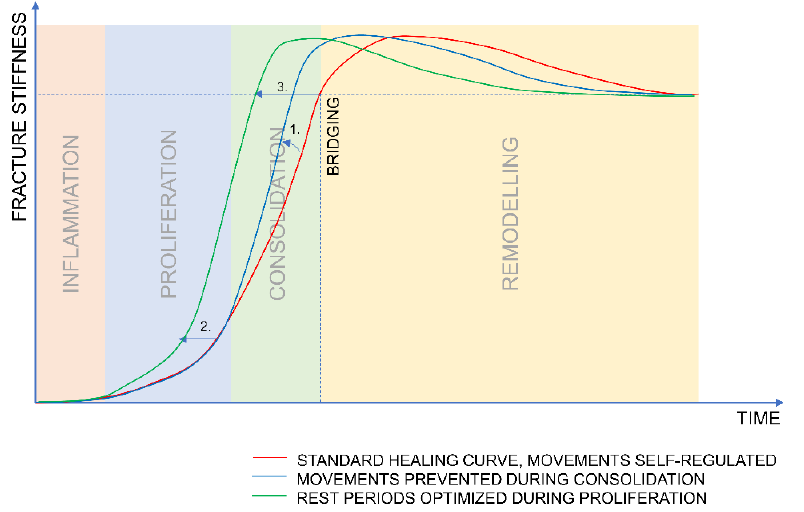
Figure 2. 1. Halting the motion during the consolidation phase increases the rate of stiffness increase. 2. Increasing the rest periods during proliferation increases the rate of tissue formation and shortens the time to consolidation; 1. and 2. combined to shorten the overall time for bridging (3.).